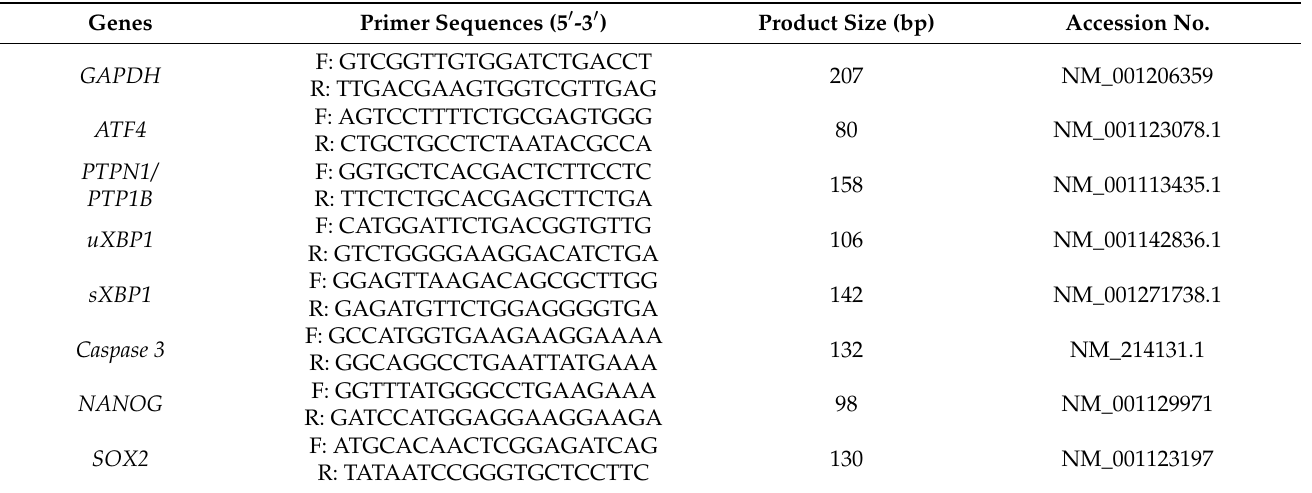
Table 2. Primer sequences for real-time